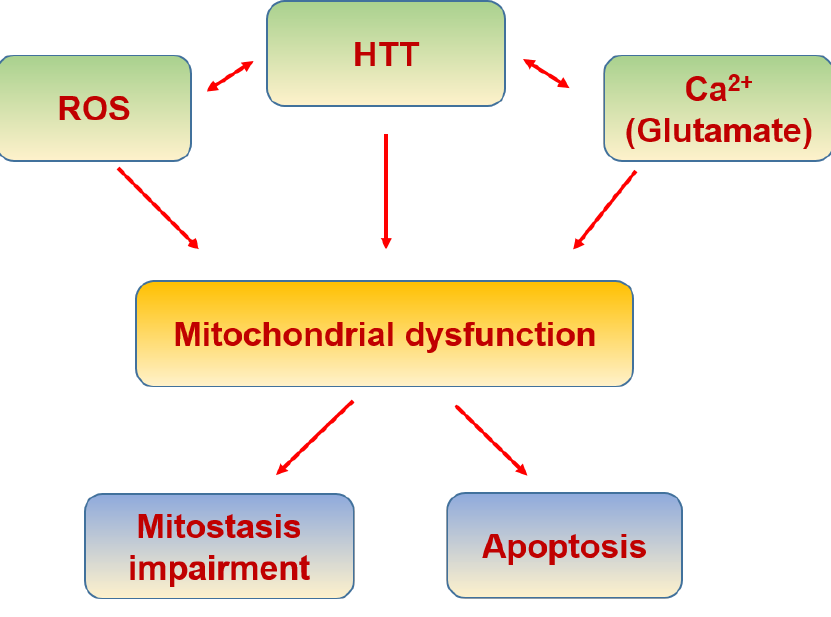
Figure 11. Huntington’s disease and mitochondria.